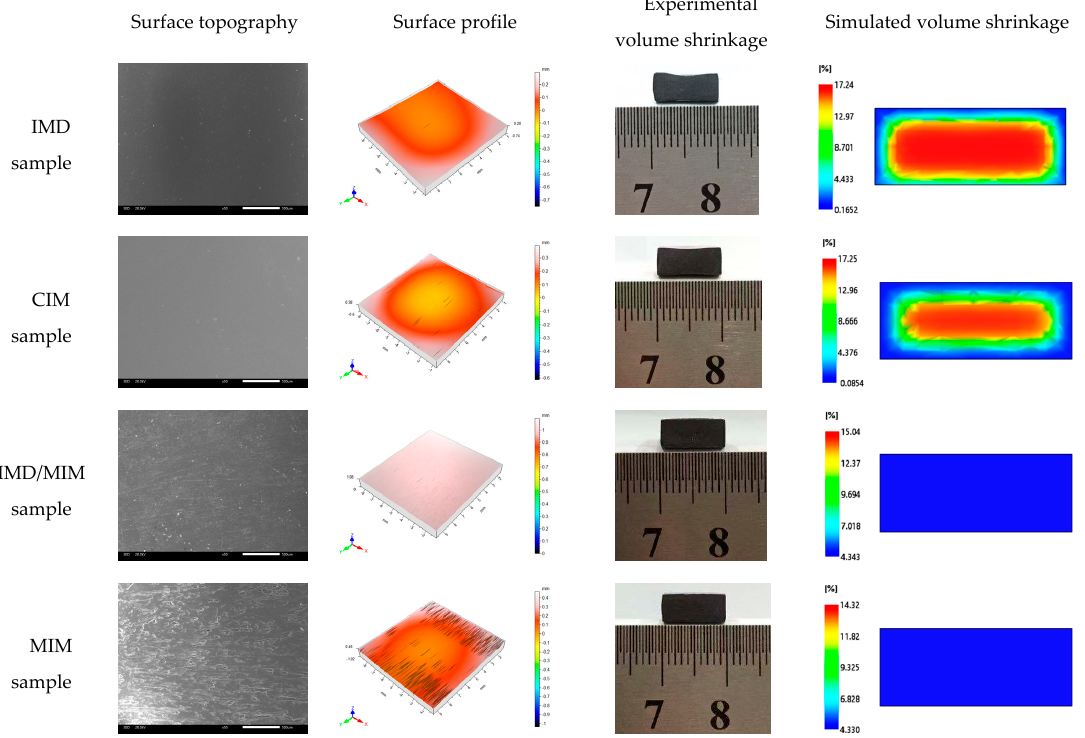
Figure 10. The comparison of the surface topography, surface profile, experimental volume shrinkage